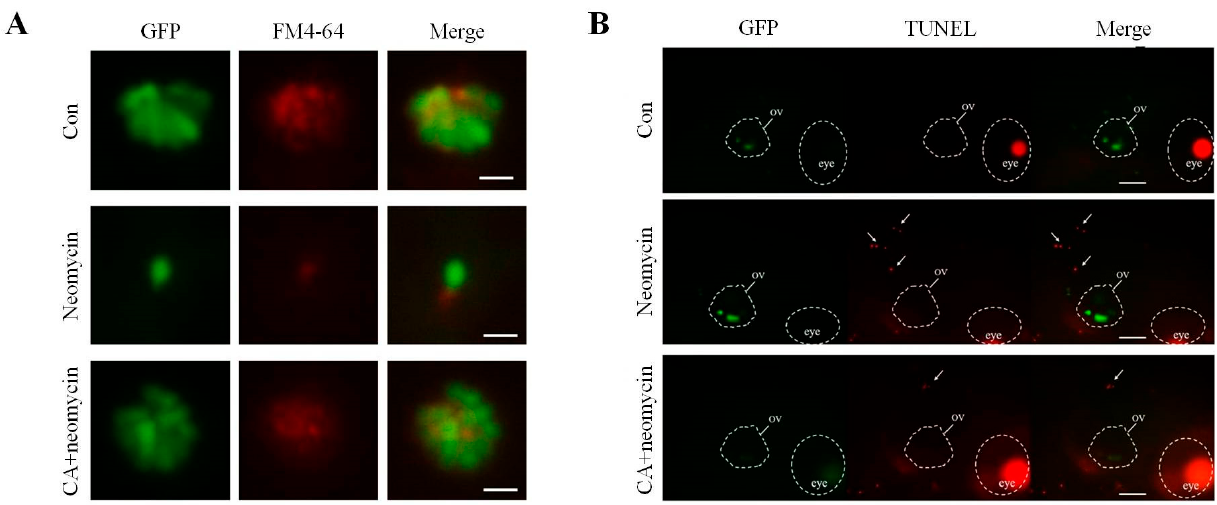
Figure 3. Evaluation of CA protected against neomycin-induced apoptosis and mechanotransduction channel impairment. ( A ) Fluorescence photograph of hair cells in neuromasts of 7-dpf transgenic zebrafish larvae treated with 12.5 μ M of neomycin for 0.5 h only or pre-treated with 5 µ M CA for 2 h. Labeling FM4-64 fluorescence dye that passes through hair’s h mechanotransduction channel was market d as a red-color signal. A comparison of the signal intensity between untreated control, neomycin, and neomycin pre-treated with CA for 2 h showed that CA prevented neomycin-induced mechanotransduction channel impairment. Scale bar: 10 μ m. ( B ) Apoptotic hair cells were marked as light-respotsot (middle le) in the anterior region of the lateral line system after TUNEL staining. The location of the oval window (ov) and eye a were marked by the white circle. Comparison of TUNEL-positive signal intensity between untreated control, neomycin, and neomycin pre-treated with CA for 2 h showed that CA prevented neomycin-induced apoptosis of TUNEL-positive cells. Scale bar: 100 μ m.